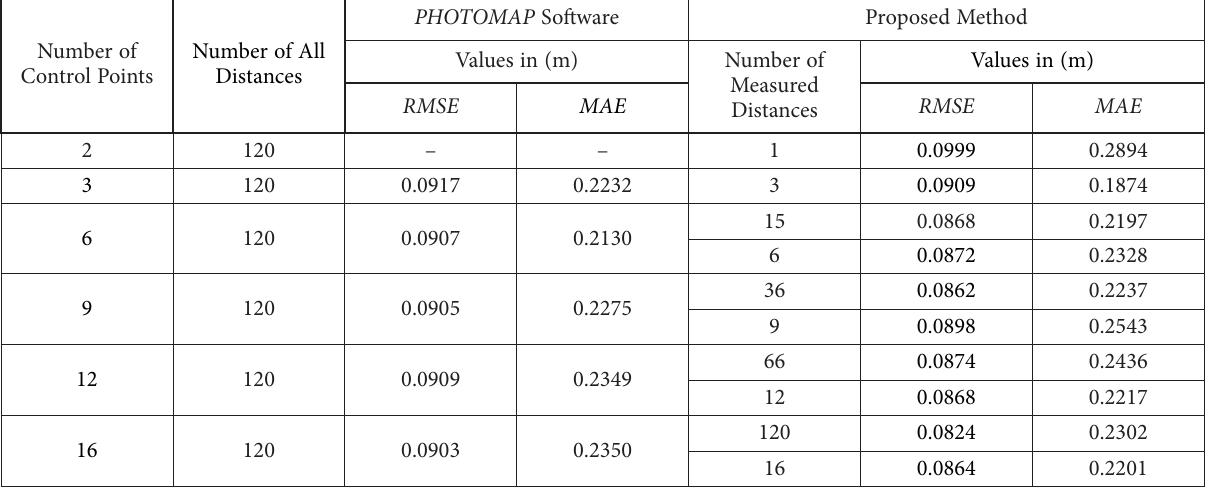
Table 4. The results of the proposed method compared to conventional method (case of aerial photogrammetry) PHOTOMAP Software Number of Number of All Control Points Distances